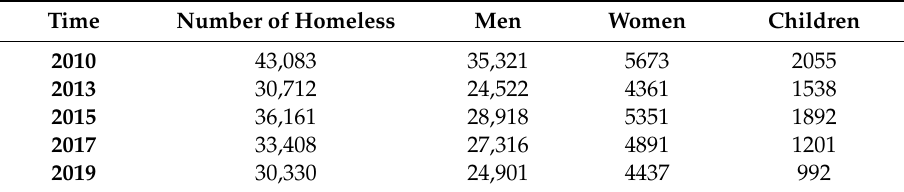
Table 1. Number of homeless in